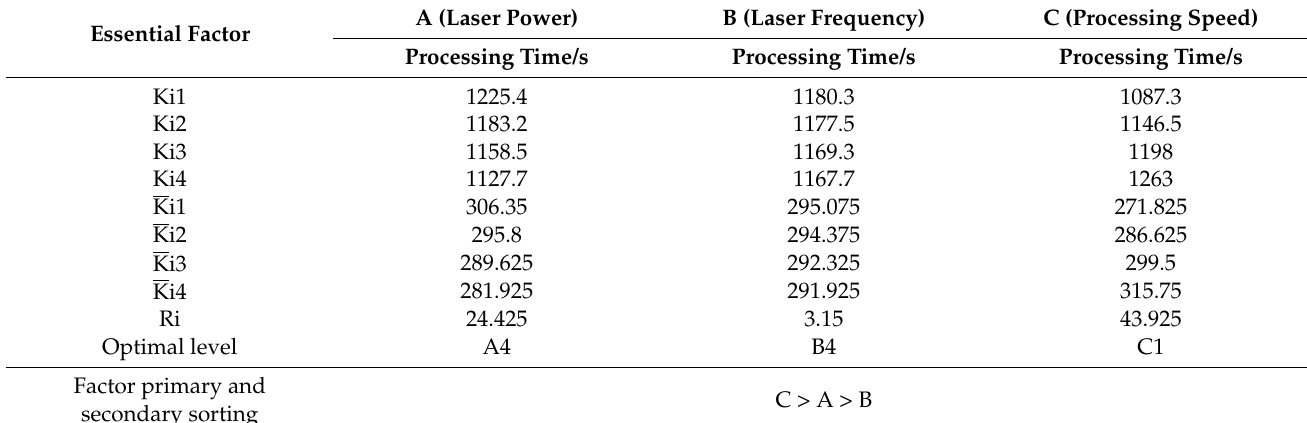
Table 10. Range analysis table of processing time of MCR frequency